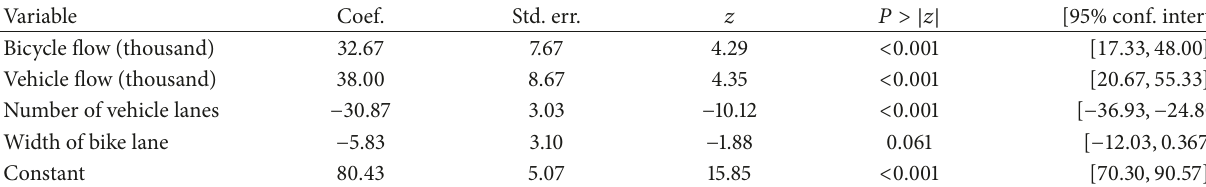
Table 2: Modeling results of vehicle